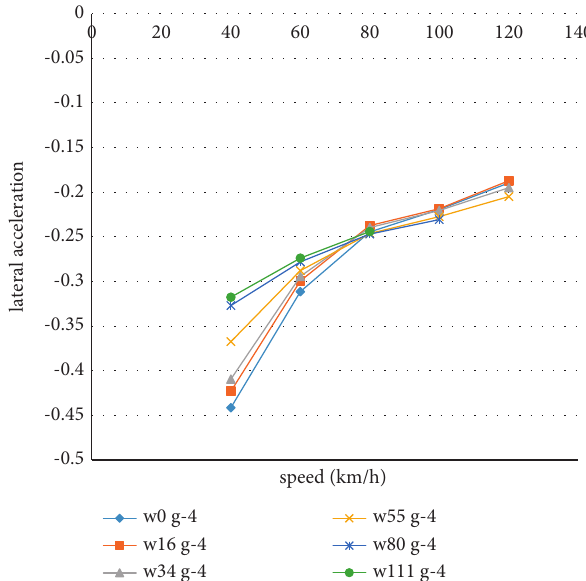
Figure 13: Comparison of maximum lateral acceleration values in terms of vehicle speed.